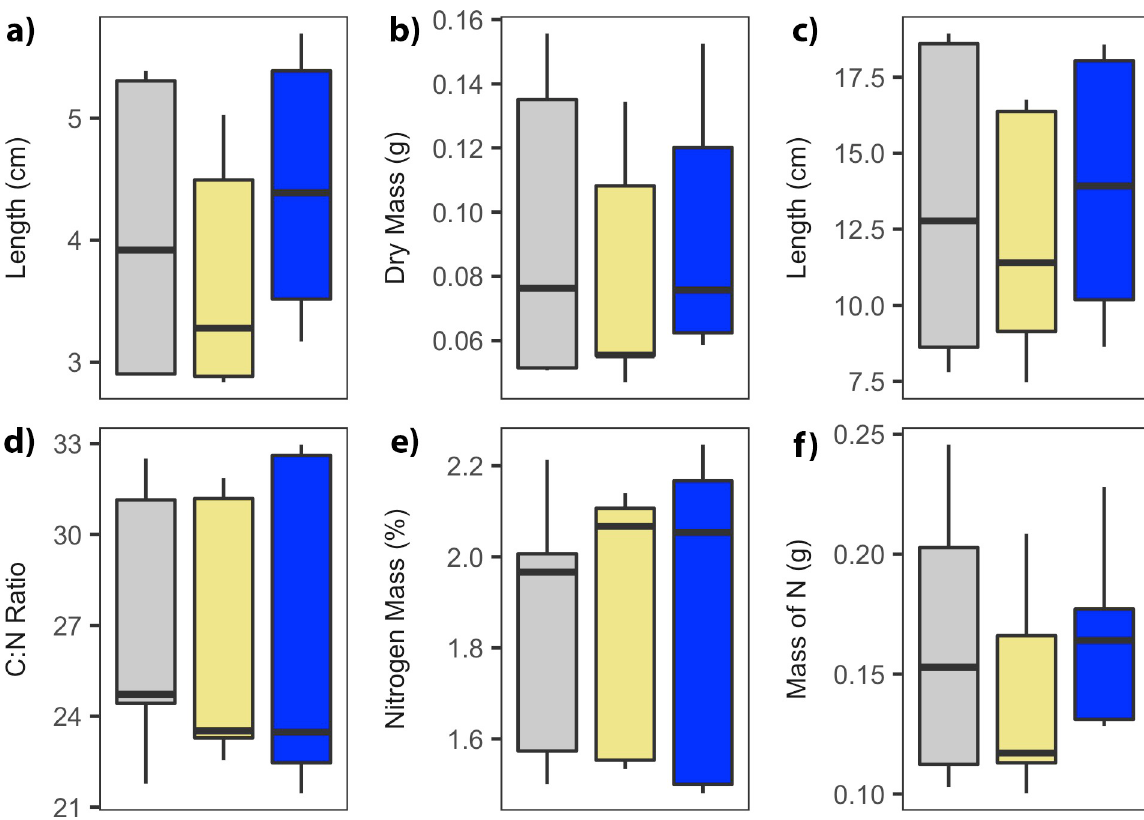
Fig 2. Growth of sagebrush leaders was unaffected by treatment application, while inflorescences decreased in length with hay addition. Treatment is indicated by color (gray = control, khaki = hay addition, blue = nitrogen addition). a) Leader length, b) leader dry mass, c) inflorescence length, d) leader C:N ratio, e) leader N content in percent, and f) leader N content in